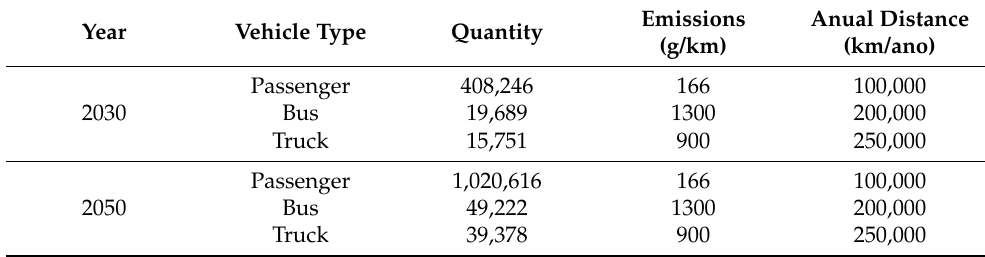
Table 13. ICE vehicles applicable for conversion.